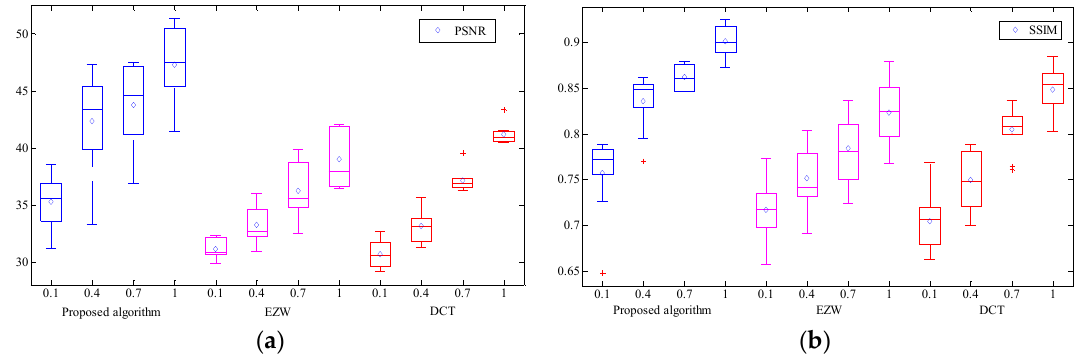
Figure 12. Comparison result of different algorithms. ( a ) Average peak signal to noise ratio (PSNR) experiment result. ( b ) Average structural similarity index (SSIM) experiment result.